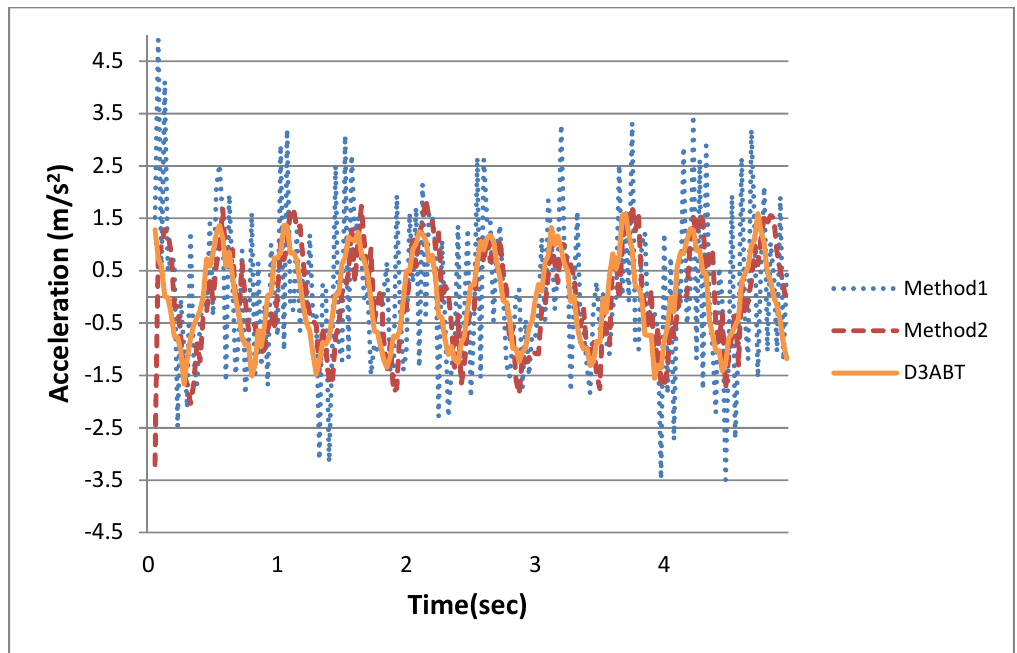
Figure 12. The comparison of walking accelerations of D3ABT, Method1, and